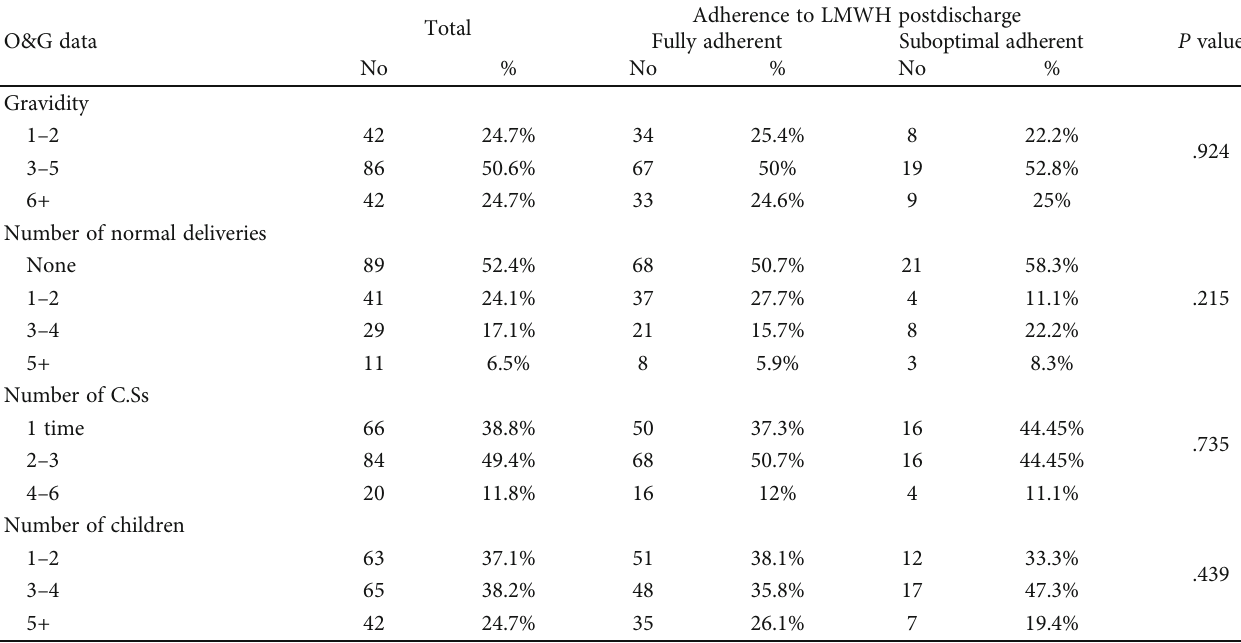
Table 4: Distribution of parturients ’ adherence to LMWH postdischarge by their gynecological and obstetric data.